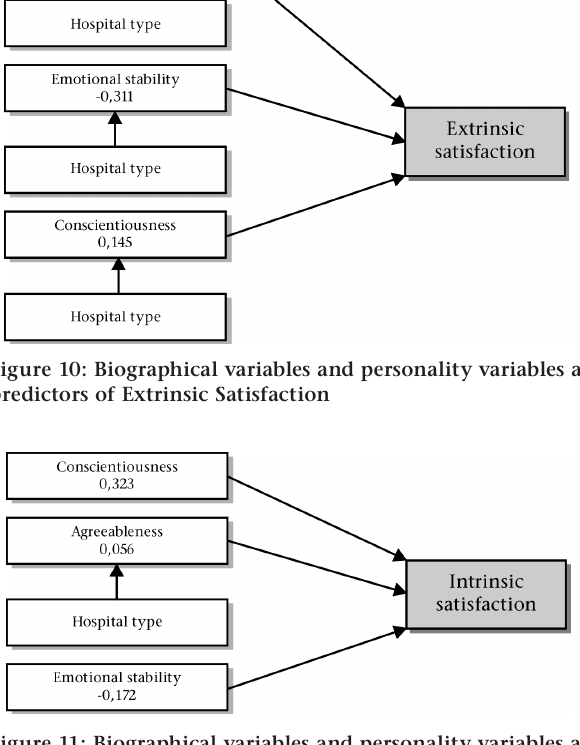
Figure 11: Biographical variables and personality variables